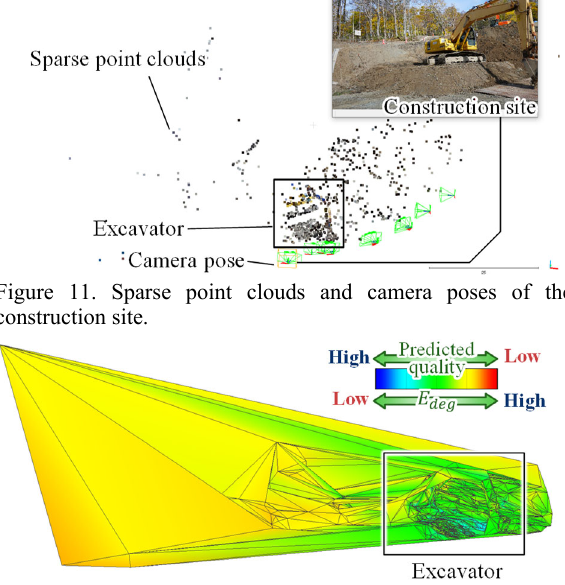
Figure 12. The estimated geometry degradation indicator